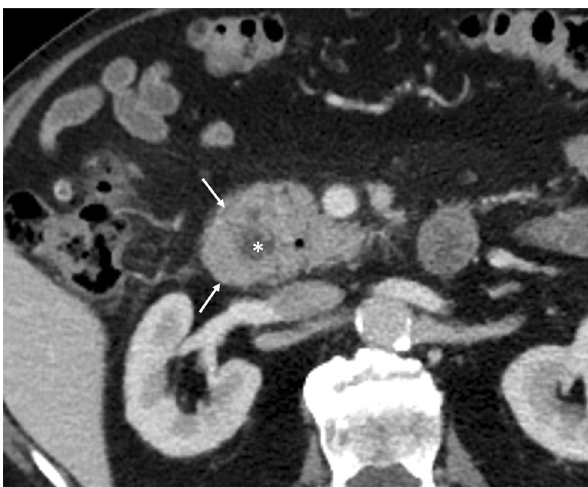
Fig. 7 Annular pancreas in a 43-year-old man with a long history of abdominal pain. Contrast-enhanced CT shows the pancreas (arrows) completely encircling the descending duodenum